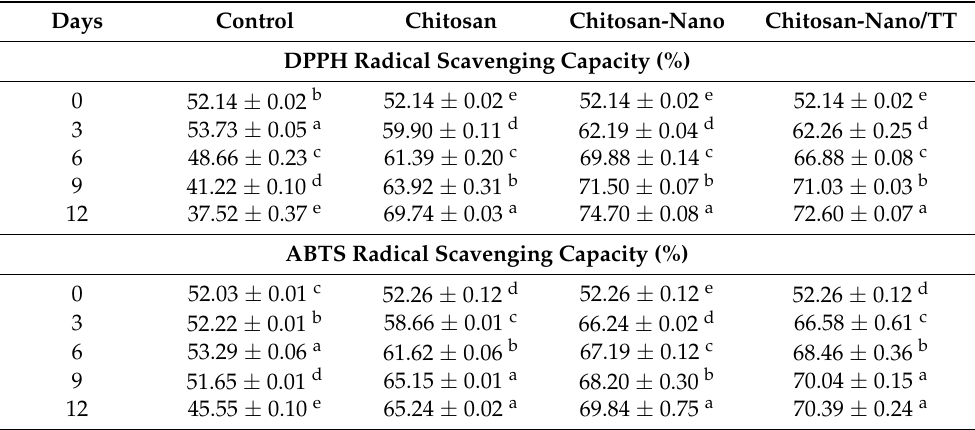
Table 1. Effect of the different coatings on antioxidant activities in mushrooms during storage. Days Control Chitosan Chitosan-Nano Chitosan-Nano/TT DPPH Radical Scavenging Capacity (%)